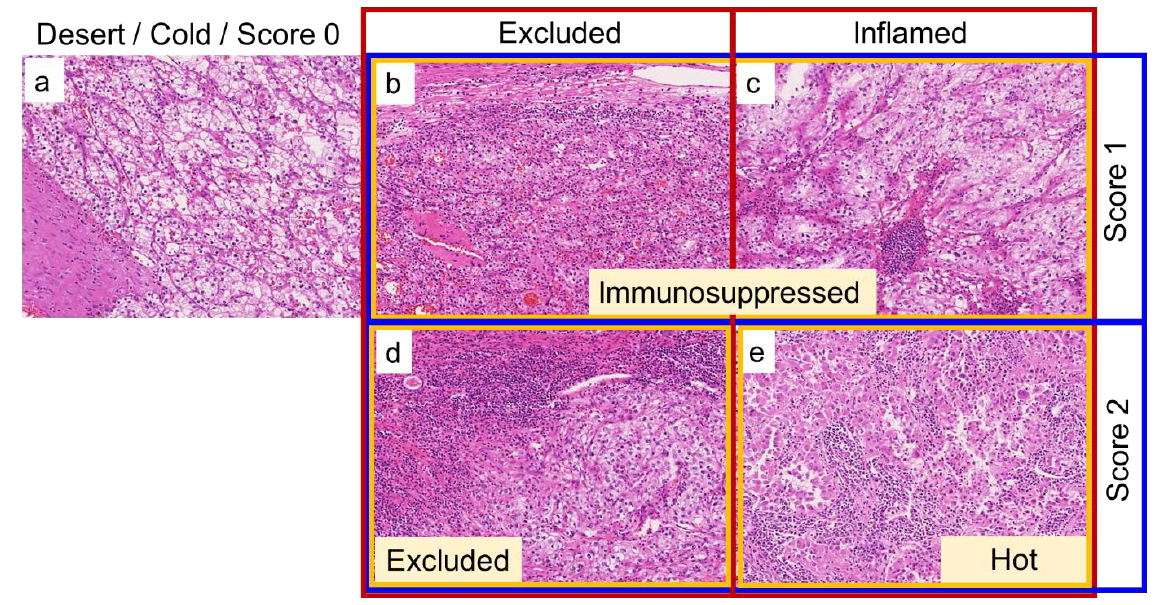
Figure 2. Representative images of how to categorize the tumor-associated immune cells (TAICs) status on hematoxylin and eosin (H&E)-stained slides. Red, yellow, and blue boxes represent the three-tier immunophenotype, four-tier immunophenotype, and inflammation score, respectively. ( a ): No TAICs, desert (three-tier immunophenotype), cold (four-tier immunophenotype), and score 0 (inflammation score). ( b ): Focal or low peritumoral TAICs, excluded (three-tier immunophenotype), immunosuppressed (four-tier immunophenotype), and score 1 (inflammation score). ( c ): Focal or low intratumoral TAICs, inflamed (three-tier immunophenotype), immunosuppressed (four-tier immunophenotype), and score 1 (inflammation score). ( d ): Diffuse or strong peritumoral TAICs, excluded (three-tier and four-tier immunophenotype), and score 2 (inflammation score). ( e ): Diffuse or strong intratumoral TAICs, inflamed (three-tier immunophenotype), hot (four-tier immunophenotype), and score 2 (inflammation score). All images are taken at 10× magnification.